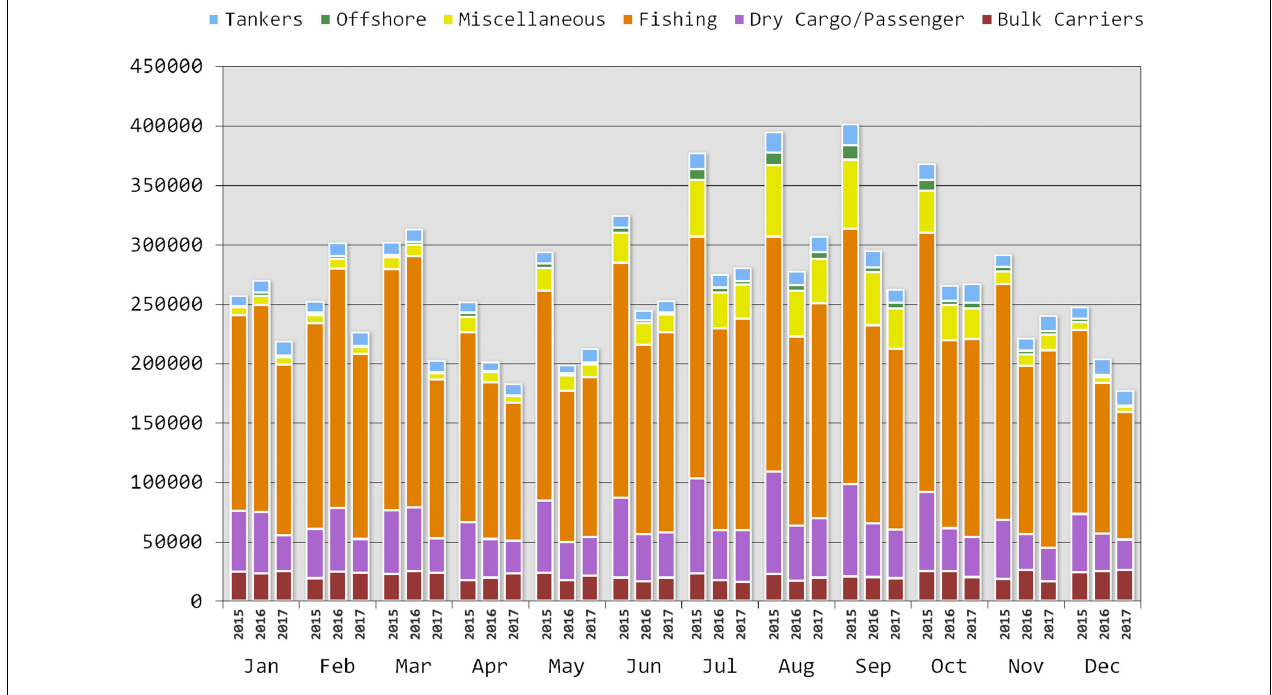
FIGURE 3 | Vessel hours of operation, by month and vessel class, in 2015, 2016, and 2017.